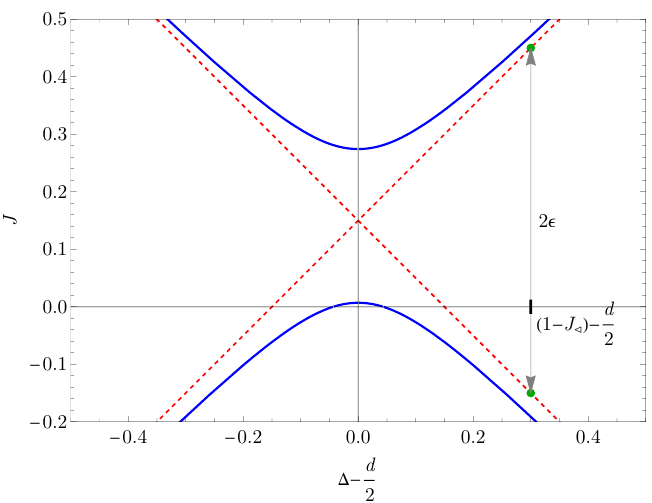
Figure 14. Free theory Regge trajectories (dashed, red), with the operators participating in the mixing at J L = J / shown as green dots. Their scaling dimensions ∆ L = 1 − J differ by 2 (cid:15) , which is the mass dimension of the coupling λ 2 µ 2 (cid:15) . The renormalized trajectory at O ( (cid:15) 2 ) is shown in solid e blue. The plot is made at (cid:15) = 0 . 3